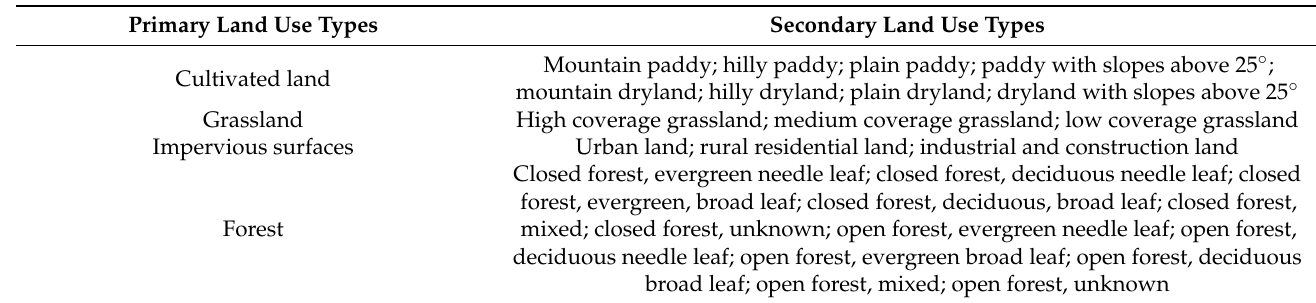
Table 3. Discrete classification types for dividing the sample selection